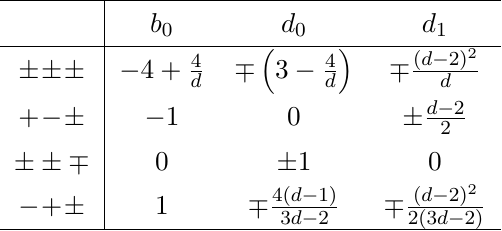
Table 5 . The coefficients for specifying the fermion Green’s function eq. (4.56) in the /∂ 3 ψ theory for the eight different possible conformal boundary